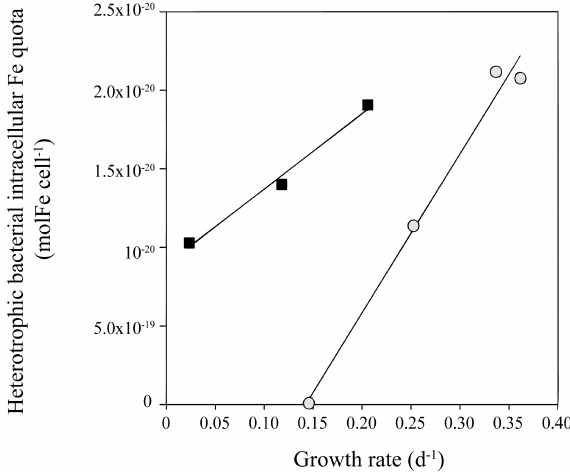
Figure 5. Relationship between the intracellular bacterial Fe quota and growth rate. Black squares: stations E-4W, E-5 and R-2; re- gression line r 2 = 0 . 99, y = 4 . 8 × 10 − 14 + 8 . 9 × 10 − 15 . Grey cir- cles: stations E-2, E-3, A3-2 and F-L; regression line r 2 = 0 . 99, y = 10 × 10 − 14 + 1 . 4 × 10 − 15 . Calculations are based on bacterial Fe uptake and growth rates measured when bacteria were incubated with pico-nanoplankton